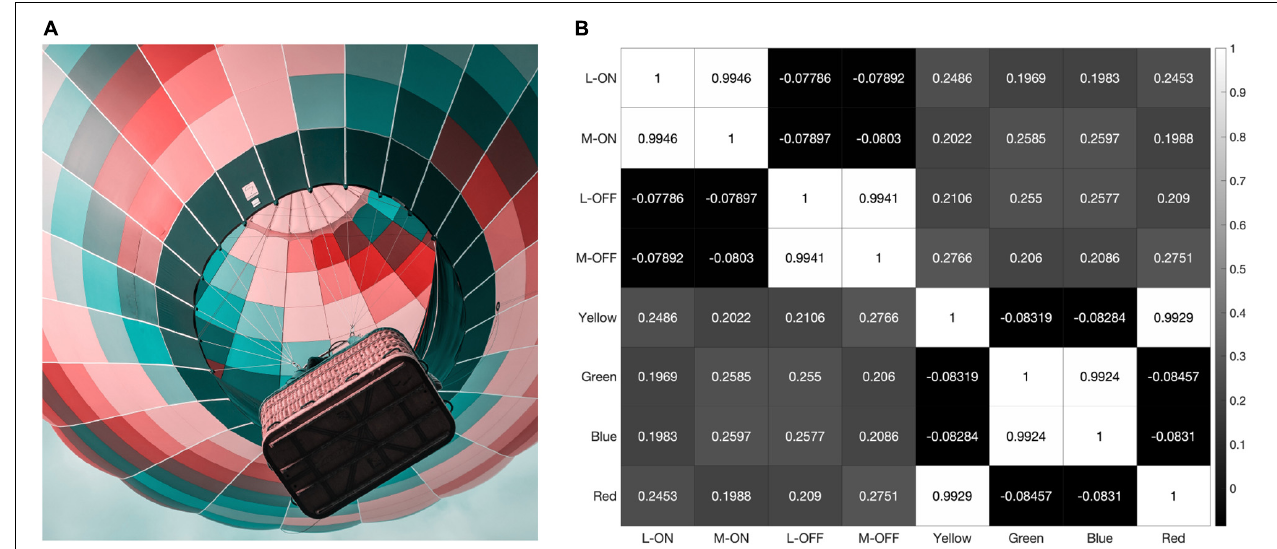
FIGURE 10 | When presented with a simulation of Trian color vision deficiency (A) the L-ON/M-ON and L-OFF/M-OFF receptive fields in the resulting correlation matrix (B) are still highly